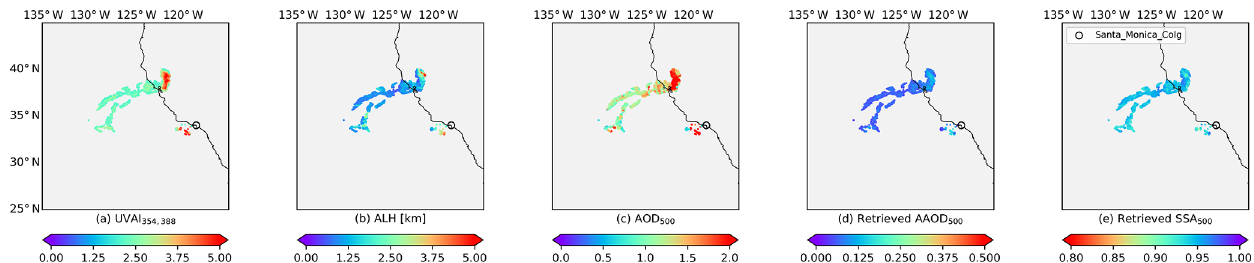
Figure 11. SVR retrievals for the Californian fire event on 9 November 2018: (a) TROPOMI UVAI calculated by reflectance at 354 and 388nm; (b) TROPOMI ALH; (c) MODIS AOD at 550nm; (d) retrieved AAOD at 500nm; (e) retrieved SSA at 500nm.